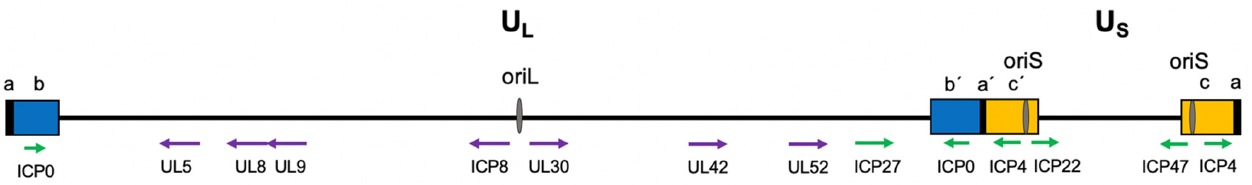
Figure 1. Diagram of the HSV-1 genome. The UL region is flanked by b and b’ (blue) inverted repeats and the US region is flanked by c’ and c (yellow). The three origins of replication (one OriL and two OriS) are designated as gray ovals. The genes that code for the seven core viral replication proteins are within the UL region (purple). IE genes that code for the IE proteins (ICP4, ICP0, ICP27, ICP22, and ICP44) are labeled green. Adapted from Lehman and Boehmer, Journal of Biological Chemistry, 1999 [33].